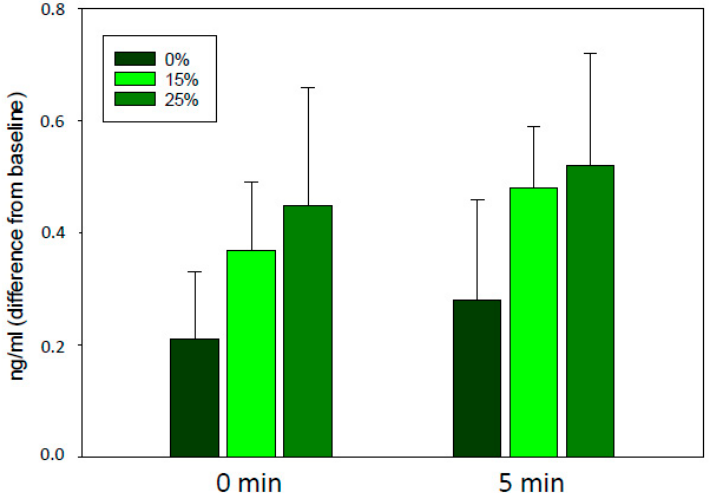
Figure 3. Salivary cortisol concentrations of the 20 horses (ng / mL, mean ± se) calculated as the di ff erence from baseline. 0% (control): The rider rode without additional weight; 15% and 25%: The rider rode with additional 15% or 25% of her bodyweight, respectively, in a balanced order across three test days. 0 and 5 min refer to the sampling time after the dressage test (0 min: F 2 = 0.58, p = 0.56, 5 min: F 2 = 0.66, p =